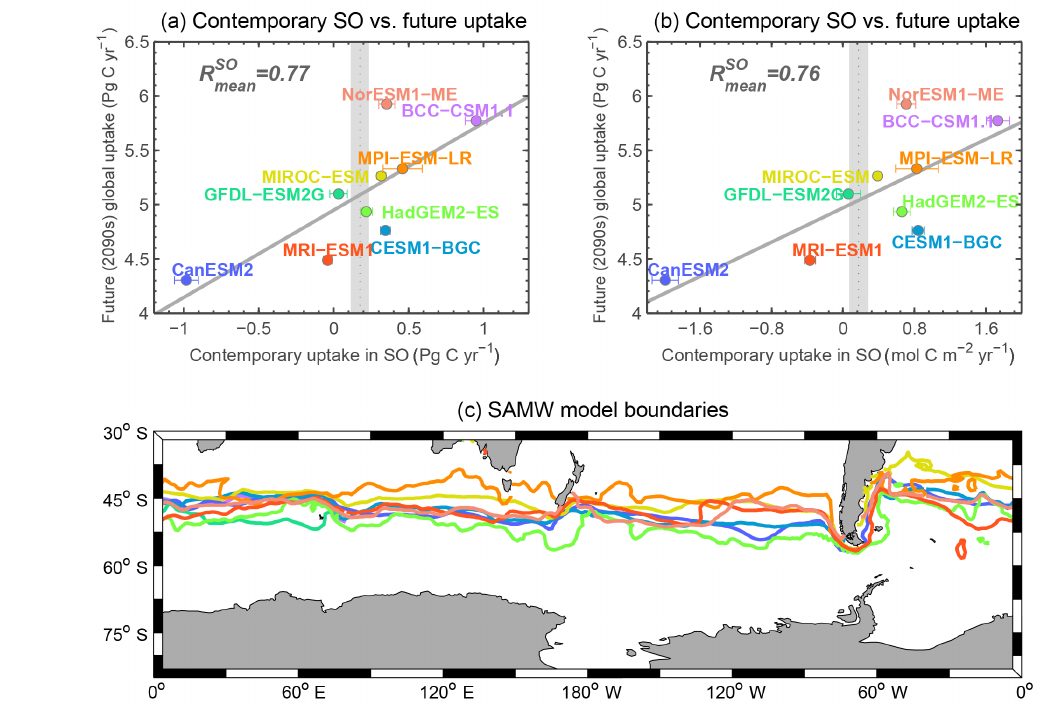
Figure 5. Annual contemporary carbon uptake vs. global uptake rate projected for the last decade of the 21st century by CMIP5 models. Here the SO is defined using dynamic boundaries separated by a surface water density of 26.5kgm − 3 . Panels (a) and (b) show the contemporary SO carbon uptake on the x axes in PgCyr − 1 and molCm − 2 yr − 1 , respectively. Panel (c) illustrates the 26.5kgm − 3 density lines that separate the MW from the TMW for the month of August 2005 as simulated by the different models (same color convention as in a and b